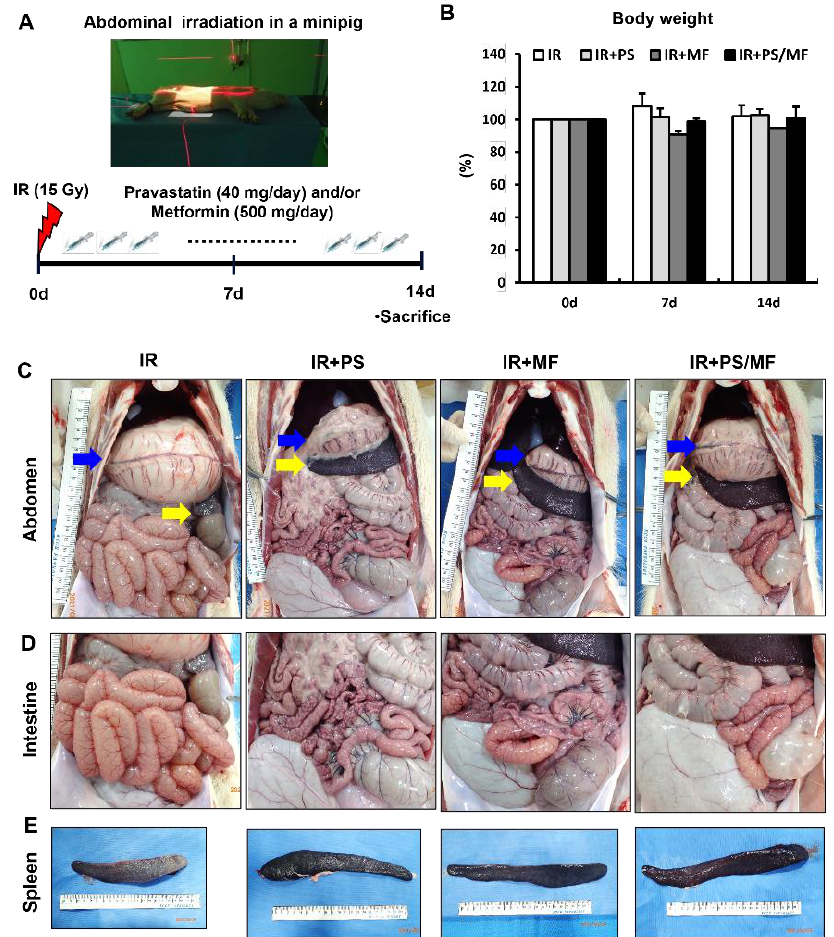
Figure 4. Effect of combined pravastatin and metformin treatment on radiation-induced damage in a minipig model: gross morphology of abdominal organs. ( A ) Schematic diagram of the minipig experimental protocol. Minipigs were treated with combination of pravastatin (PS) and metformin (MF) by oral administration after receiving a single dose of 15Gy gamma-ray radiation to the whole abdomen. ( B ) Body weights of minipig in irradiated (IR), PS-treated IR (IR + PS), MF-treated IR (IR + MF), combined PS and MF-treated IR (IR+PS/MF) groups after 15Gy irradiation. ( C ) Gross pathology of abdominal organs, ( D ) intestine, and ( E ) spleen at 14 days after irradiation of IR, IR + PS, IR + MF, IR + PS/MF groups. Blue arrows indicate stomach. Yellow arrows indicate